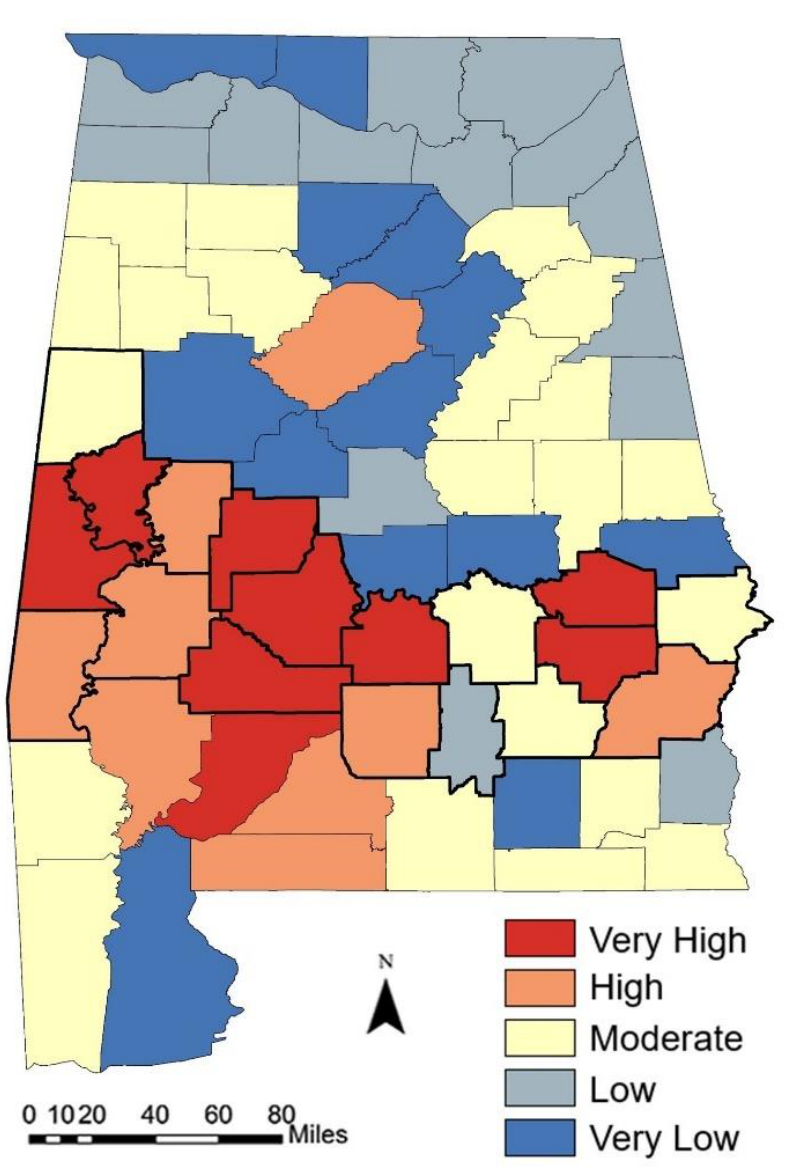
Figure 5. Spatial distribution of the sensitivity subindex. The scores are classified as quintiles. The thick black lines indicate the boundaries of Black Belt counties.